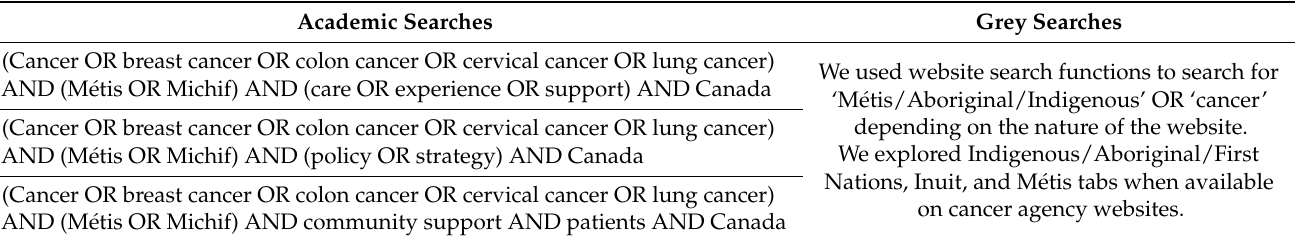
Table 2. Search terms and combinations